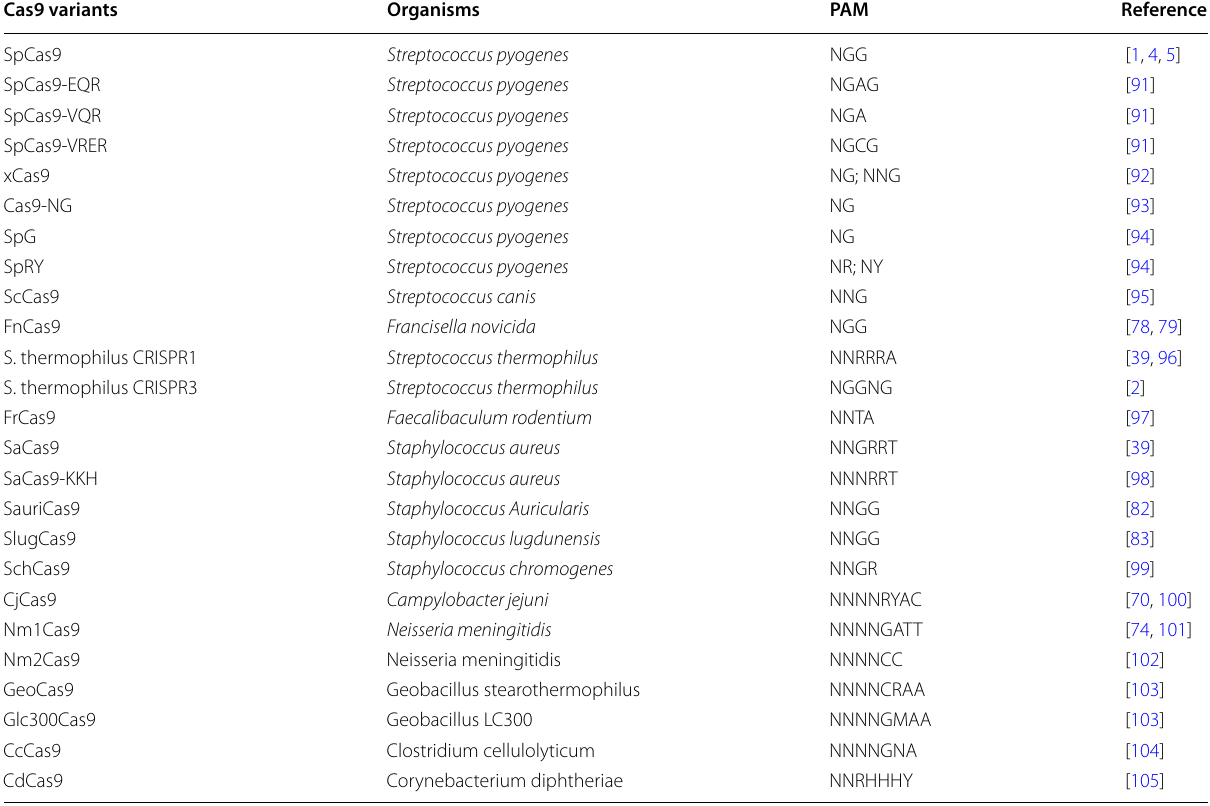
Table 1 Cas9 and their respective PAM sequences Cas9